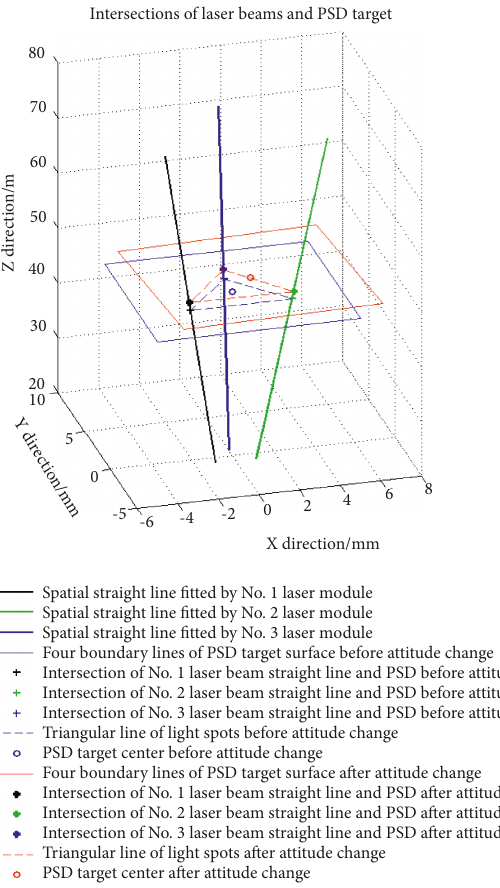
Figure 9: Intersection between the PSD and laser beams before and after attitude